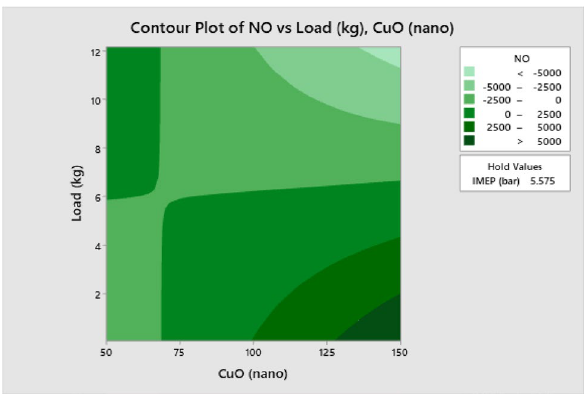
Fig. 34 Contour plot of NOx with nanoparticles